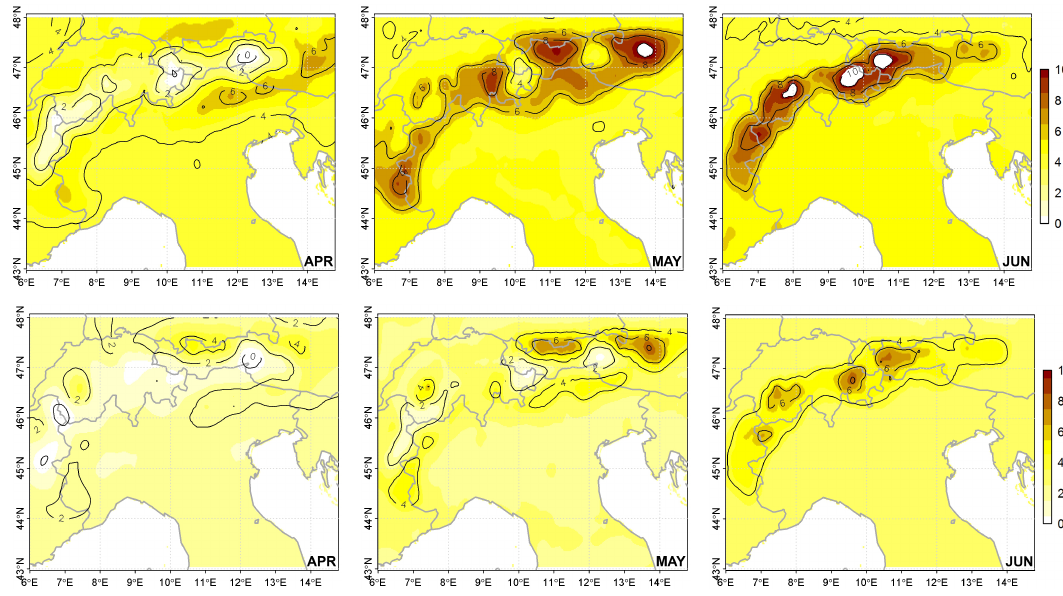
Figure 5. Soil temperature differences (in ◦ C) in the surface soil layer between FC A 2 and the RC ( upper panels ) and between FC B 2 and the RC ( lower panels ) for April, May, and